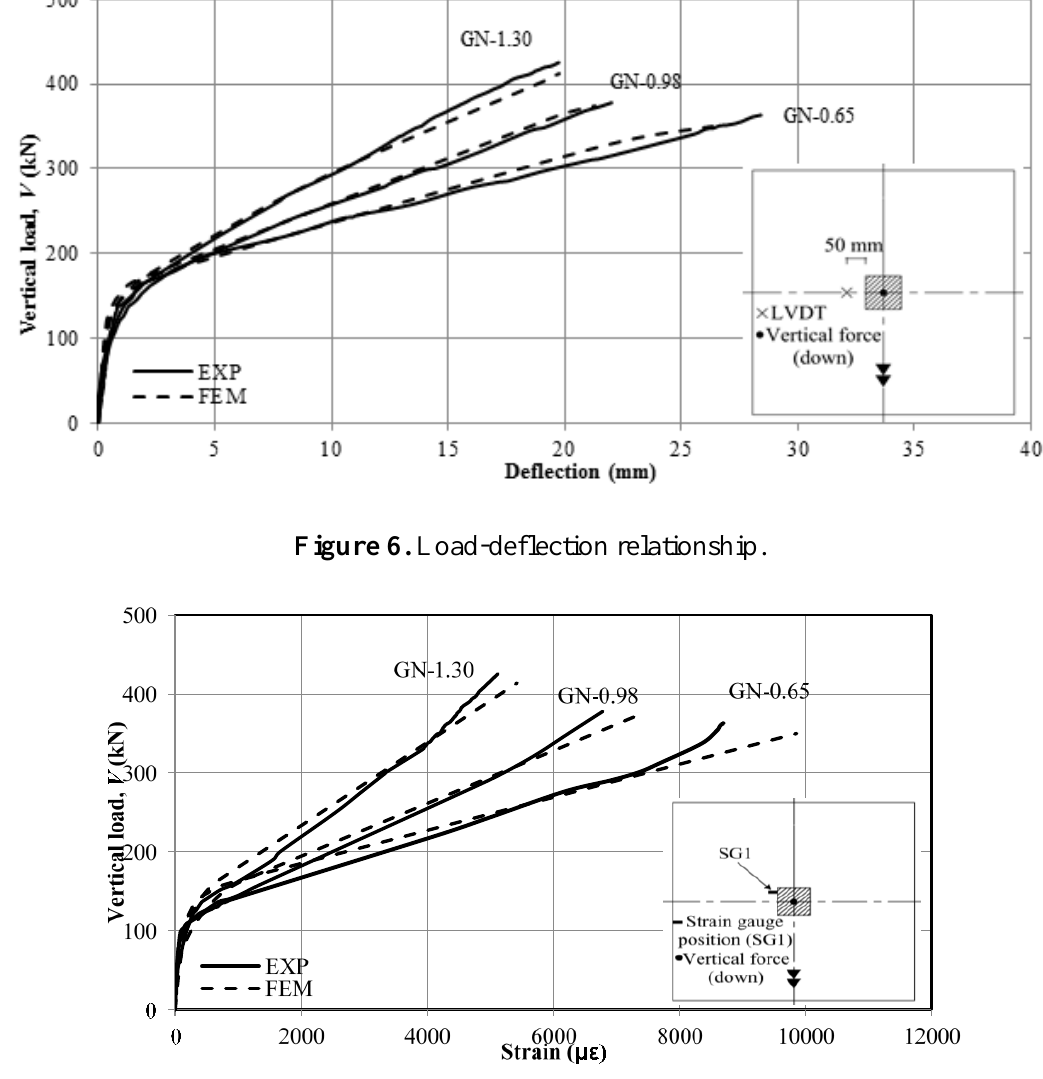
Figure 7. Load-strain